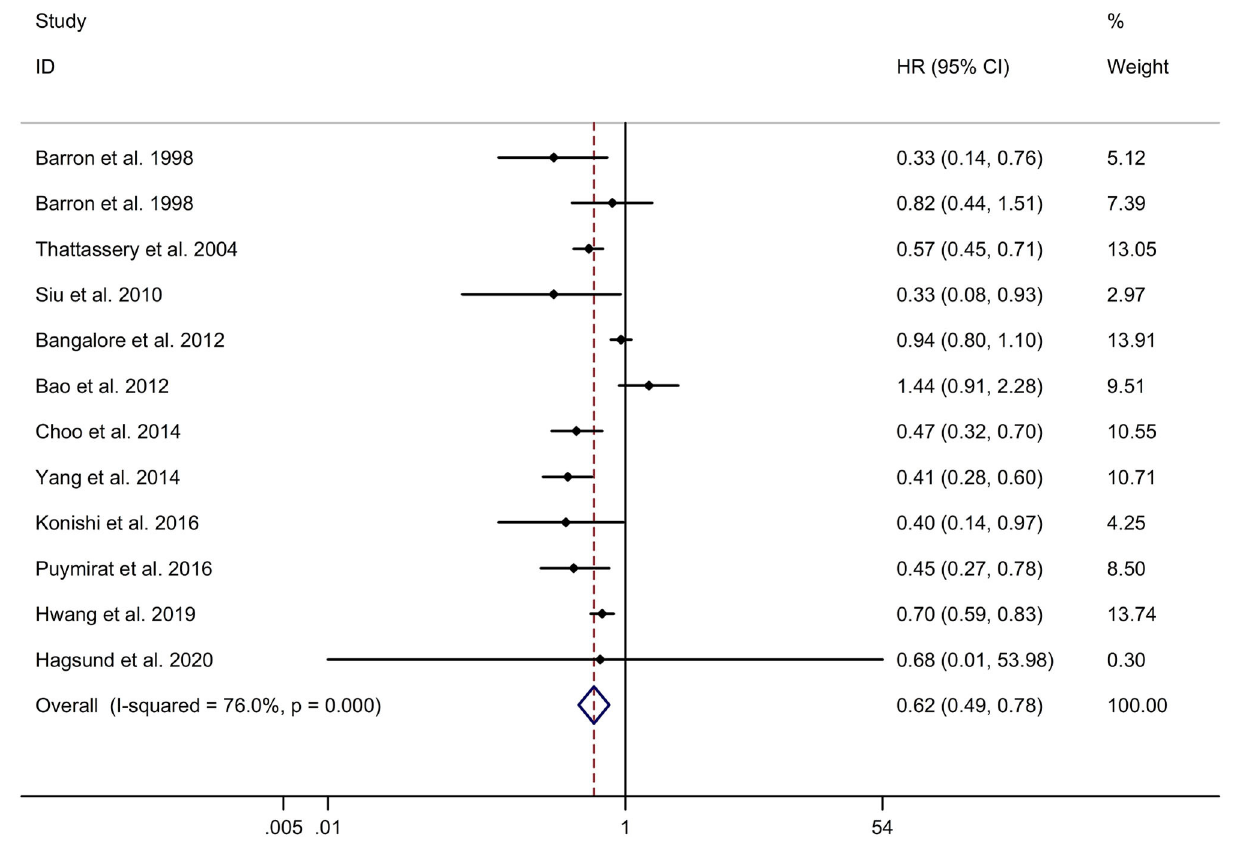
Frontiers in Cardiovascular Medicine |